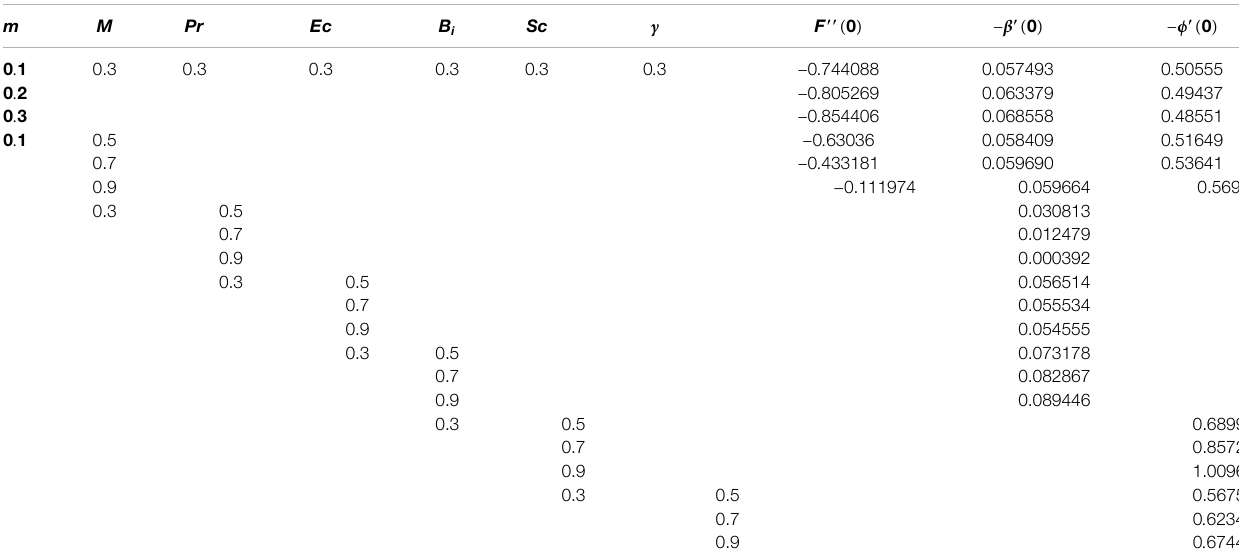
TABLE 2 | Numerical values for skin friction coef fi cient and local Nusselt and Sherwood